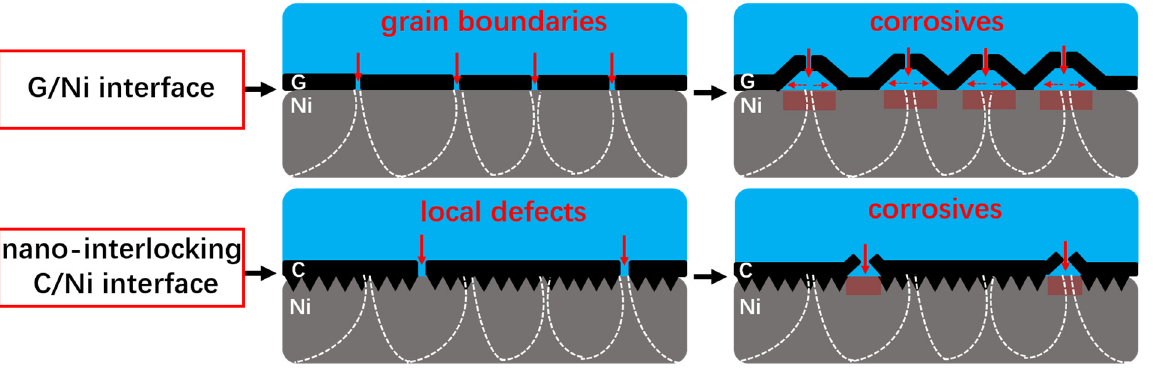
Figure 8. Schematic illustrating the corroding process occurred at the coating/metal substrate interface for the FDC and graphene-coated Ni samples.